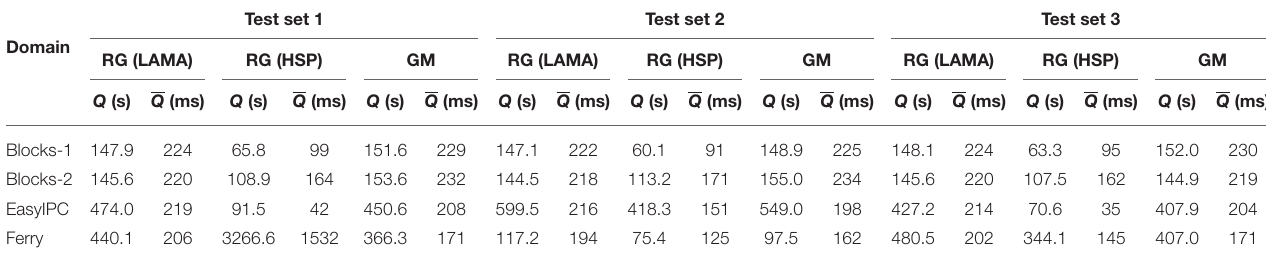
TABLE 8 | Total processing time in seconds ( Q ) for all Intervention problems in set 1, 2, and 3 and the mean processing time in milliseconds for each incrementally revealed observation ( Q ) for recognizing undesirable states with the algorithms: probabilistic goal recognition using satisficing (RG-LAMA) and optimal (RG-HSP) plans and goal mirroring (GM) using the JavaFF